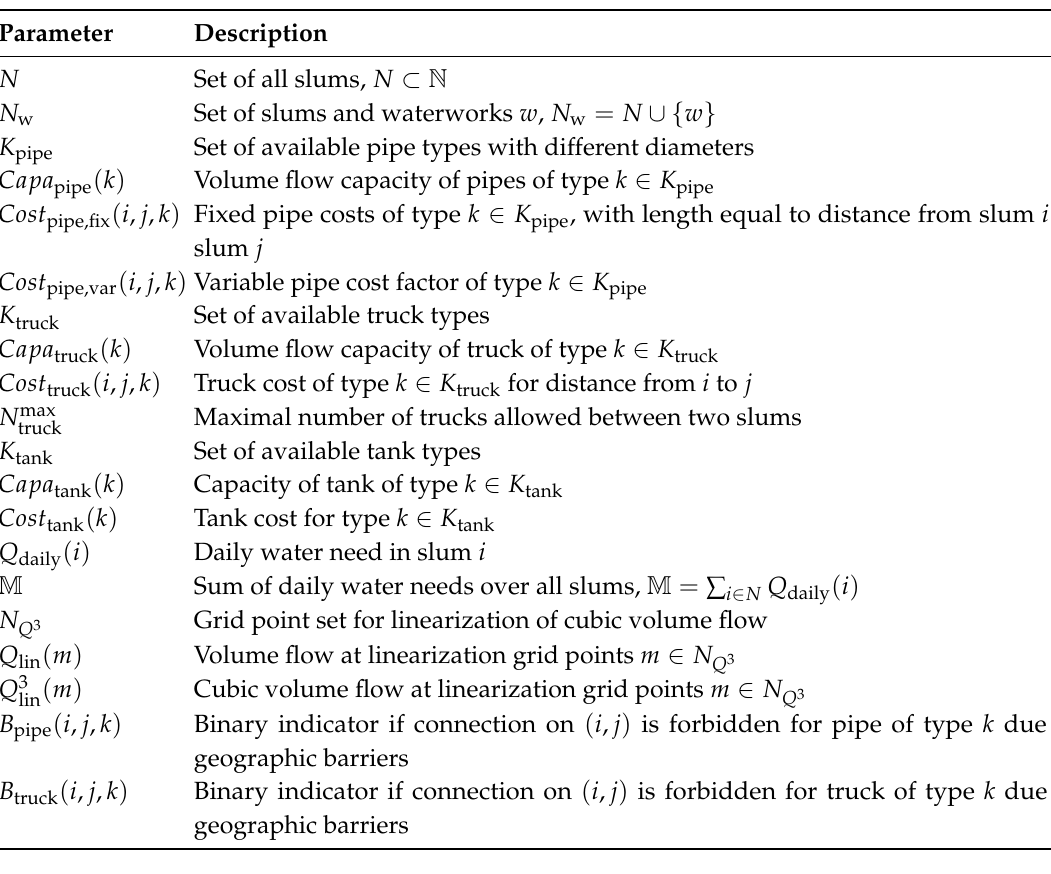
Table A1. Parameters of the mixed-integer